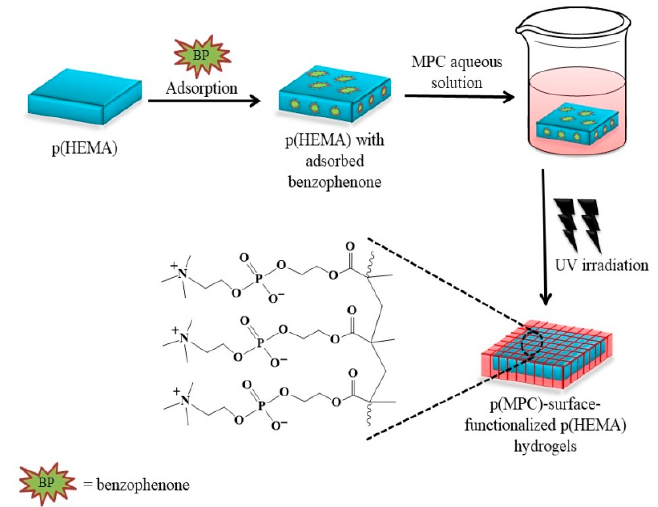
Table 1. Characteristics of the poly(2 ‐ methacryloyloxyethyl phosphorylcholine) ‐ surface ‐ functionalized